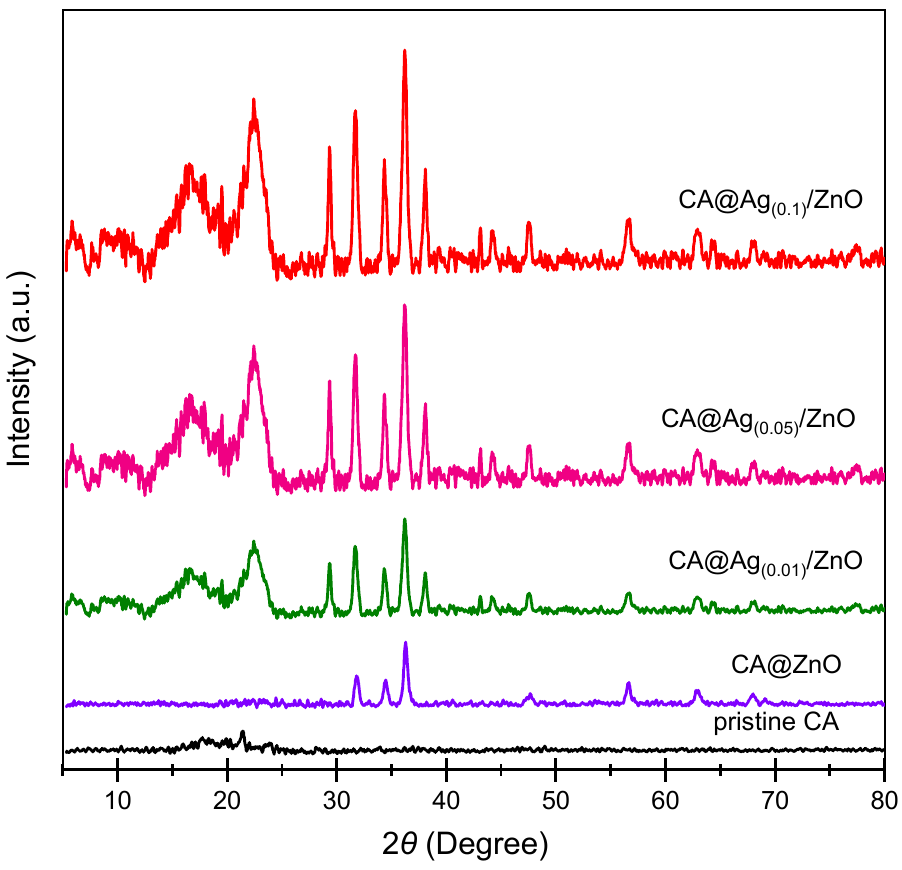
Figure 1. PXRD diffractograms of pristine CA, CA/ZnO, and CA@Ag (0.01, 0.05, 0.1) /ZnO hybrid mem- branes.